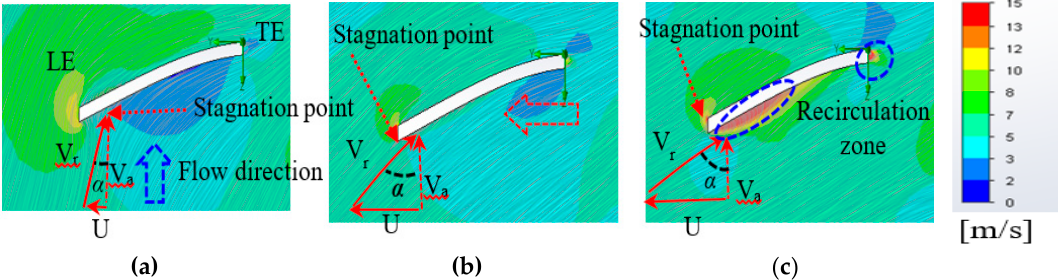
Figure 14. Velocity distribution mid span of the flow passage for various TSR : ( a ) TSR = 1.0; ( b ) TSR Figure14. Velocitydistributionmidspanoftheflowpassageforvarious TSR :( a ) TSR = 1.0; ( b ) TSR = 2.5; = 2.5; ( c ) TSR = 4.0. ( c ) TSR =